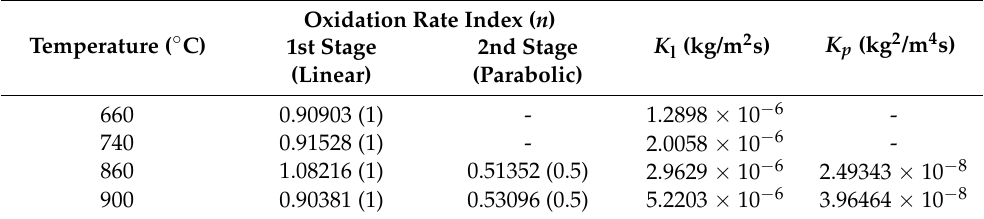
Table 1. Kinetic parameters determined from the thermogravimetric analysis of the Ni-based alloy under study.